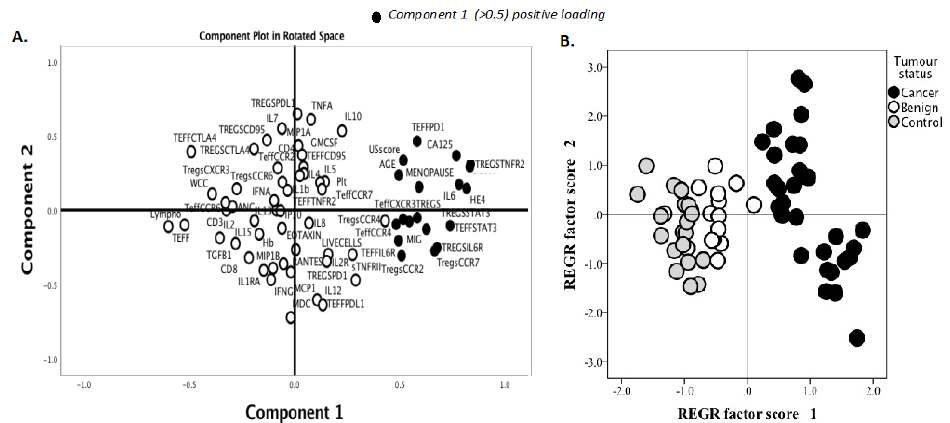
concentrations of IL-6 below the detection range (less than 0.5 pg/mL).